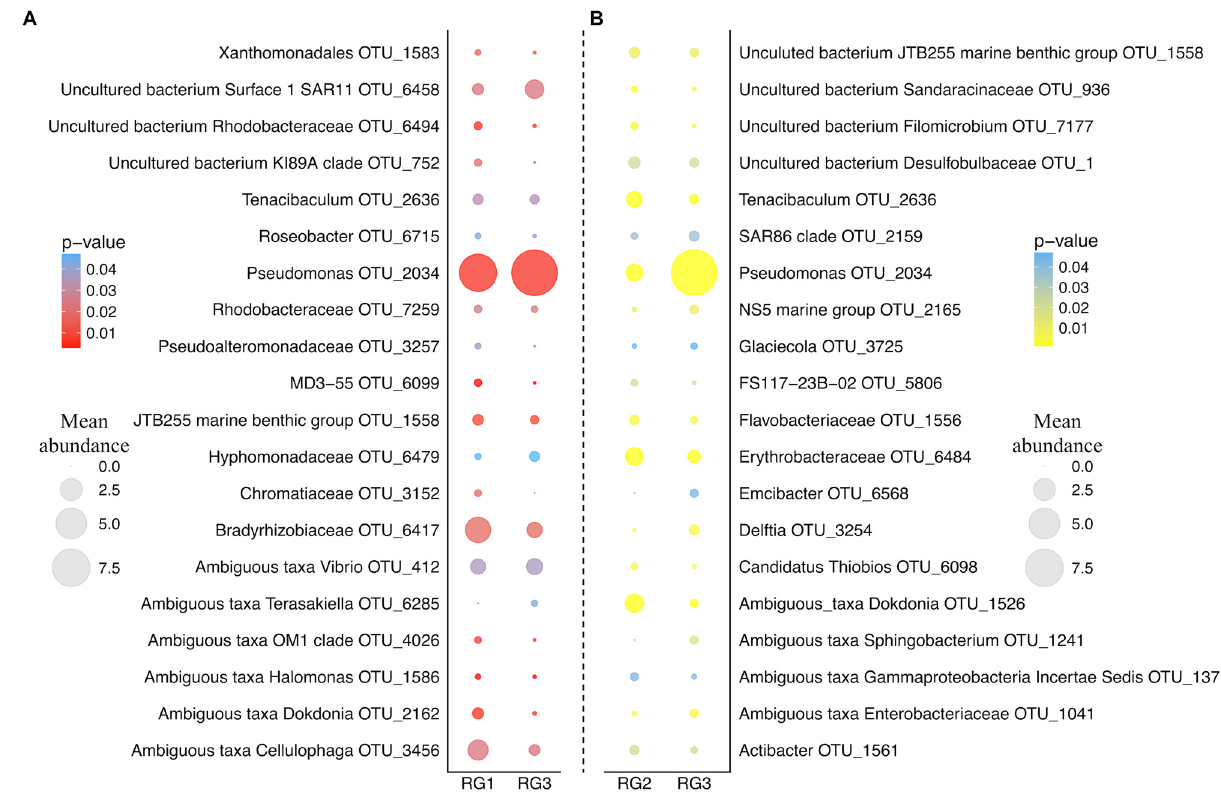
FIGURE 2 | Bubble plot of group_significance.py analysis results using the default Kruskal–Wallis parameters. (A) Represents the comparison between RG1 and RG3. (B) Represents the comparison between RG2 and RG3. Color represents the strength of the p -value. Size represents the mean relative abundance of that OTU across the whole resistance group (RG). OTUs assigned to the genus and species level were chosen, and those 20 most abundant from each RG are